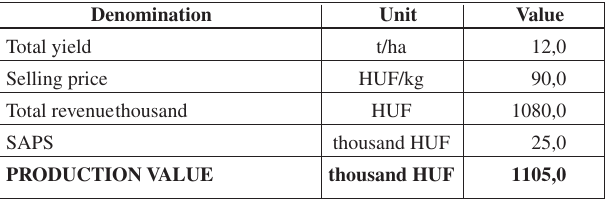
Table 3. Revenue and production value in sour cherry production